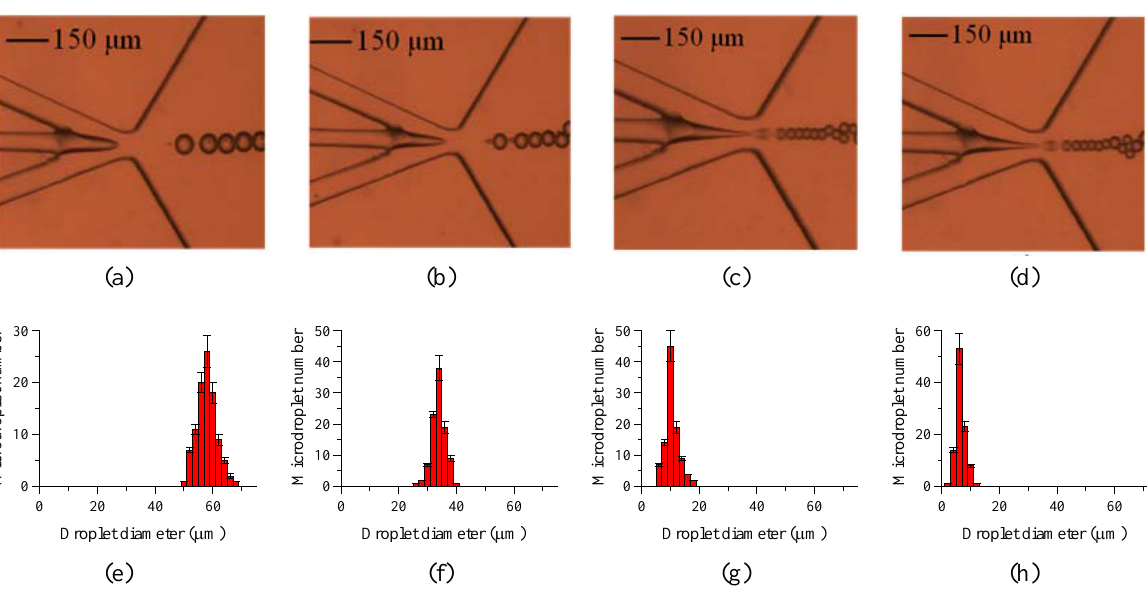
Figure 5. Formation of micro-droplets using the NC micro-valve with different applied absolute pressures. The size of the emulsion droplets can be precisely controlled using the micro-valve operated at different applied absolute pressures. Average droplet diameters are measured to be ( a ) 58 μm (for 4.5 psi), ( b ) 34 μm (for 10.4 psi), ( c ) 10 μm (for 14.2 psi), and ( d ) 5.5 μm (for 14.7 psi), respectively. The histograms of size distributions with a total number of 100 micro-droplets for applied absolute pressures of ( e ) 4.5 psi, ( f ) 10.4 psi, ( g ) 14.2 psi, and ( h ) 14.7 psi, respectively. The CVs in droplet sizes were measured to be 3.8%, 3.3%, 2.9%, and 2.5%, respectively. The V and V are set at 30 and 50 μm/s, 1 2 respectively. The droplet diameter without applying any suction force is 5.5